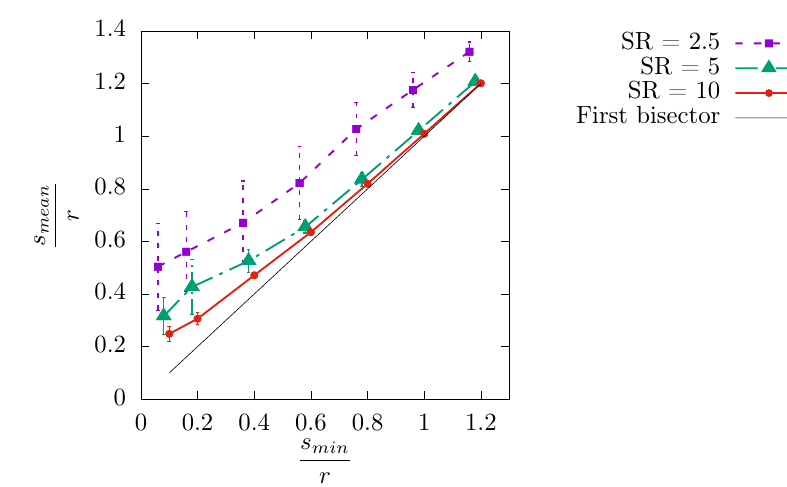
Figure 3. Mean distance between two spheres s mean as a function of s min for different scaling ratios. For clarity, the error bars and dots are slightly shifted around for each studied minimum